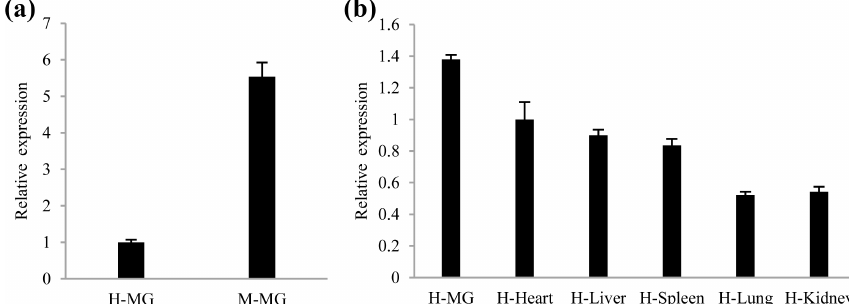
Figure 3. Relative expression of miR-130b-5p . (a) Relative expression of miR-130b-5p in healthy and mastitis-infected mammary gland tissues using qPCR. H-MG denotes healthy mammary gland and M-MG denotes mastitis-infected mammary gland. (b) Relative expression of miR-130b-5p in a variety of healthy tissues using qPCR. H denotes the healthy cow group. The vertical bar represents the standard